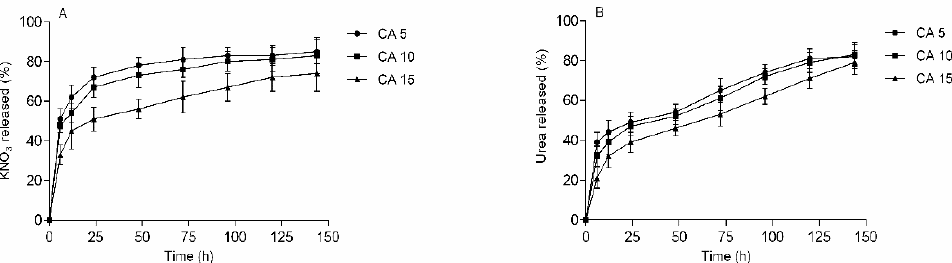
Figure 9. Release of ( A ) KNO3 and ( B ) urea from the hydrogel formulations; the experiments were performed in distilled water at room temperature; data refers to mean values ± SD (n = 3).